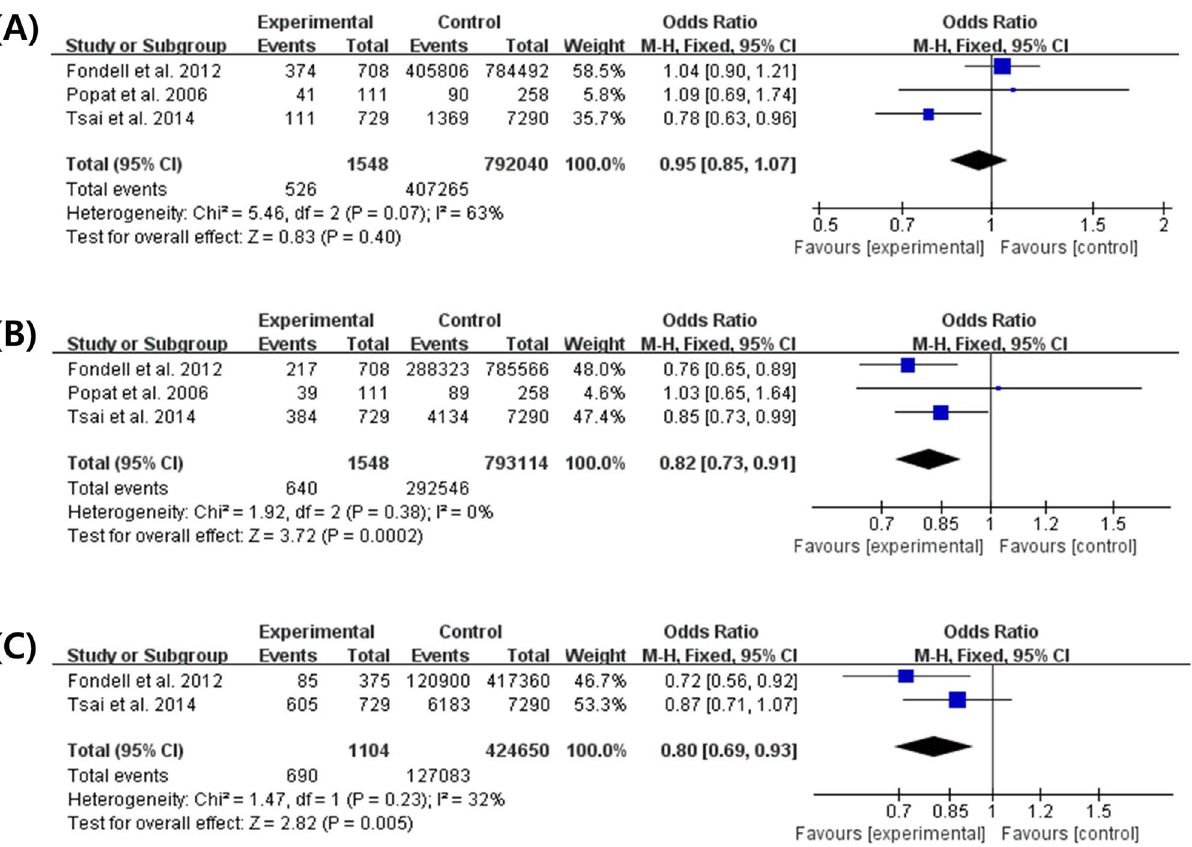
Figure 2. Forest plot of aspirin, non-aspirin non-steroidal anti-inflammatory drugs (NA-NSAIDs), and acetaminophen use in patients with amyotrophic lateral sclerosis versus controls. Note: Three studies were included. Regarding to aspirin, there was no statistically significant difference in aspirin use between the ALS and controls groups (Odds ratio, 1.04 [95% confidence interval, 0.90–1.21]) ( A ). Regarding to non-aspirin NSAIDs and acetaminophen, however, there were statistically significant differences in NA-NSAIDs ( B ) and acetaminophen ( C ) use between the ALS and controls groups. (Odds ratio, 0.82 [95% confidence interval,